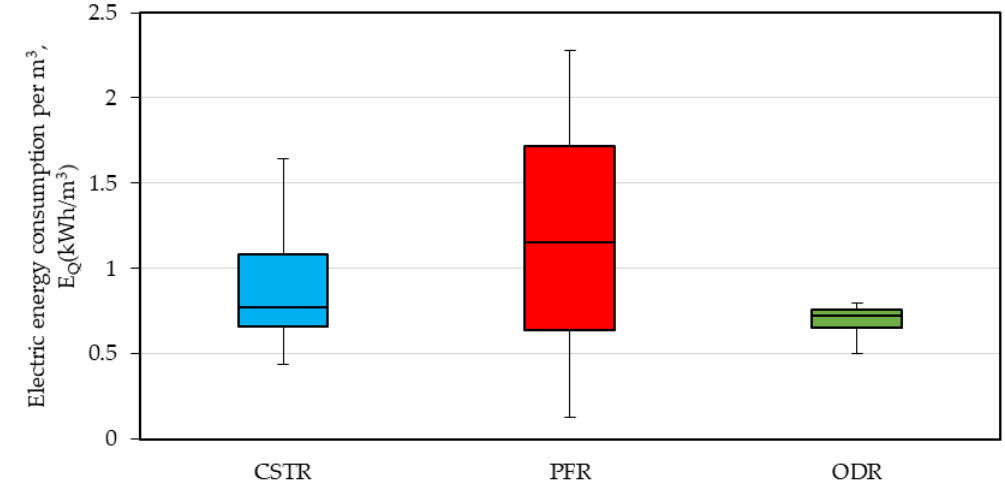
Figure 10. Electric energy consumption per volume unit of treated wastewater, E Q (kWh / m 3 ) for the 17 WWTPs, with error bars and median, classified as a function of the type of the aeration process: continuous stirred tank reactor (CSTR) (blue box); plug flow reactor (PFR) (red box); oxidation ditch reactor (ODR) (green box).